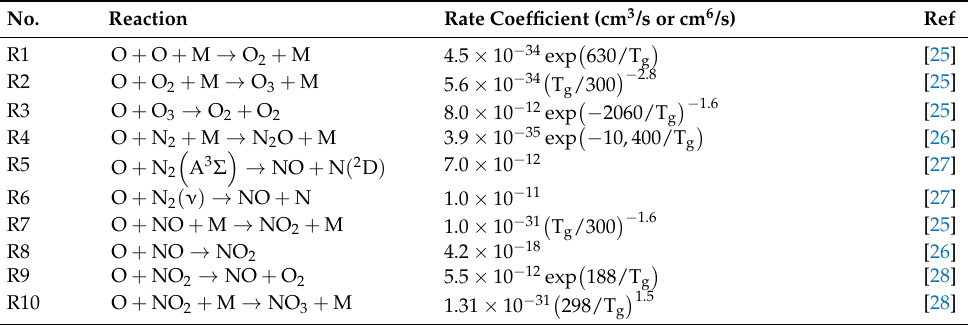
Table 1. Chemical reaction list used in